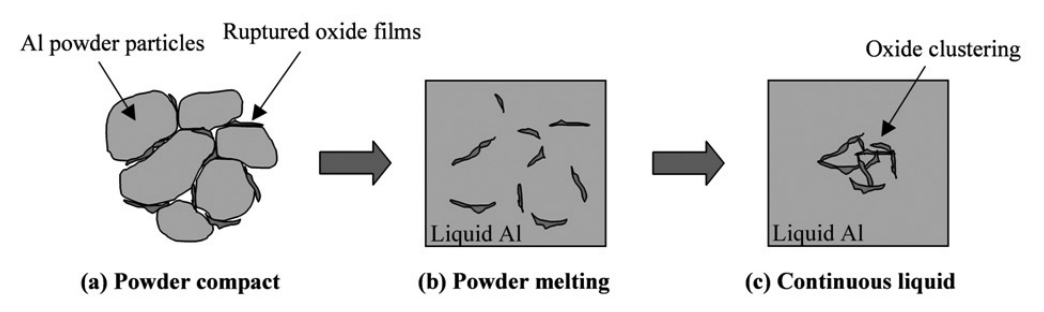
Figure 8. A schematic illustration showing the formation of oxide clustering.